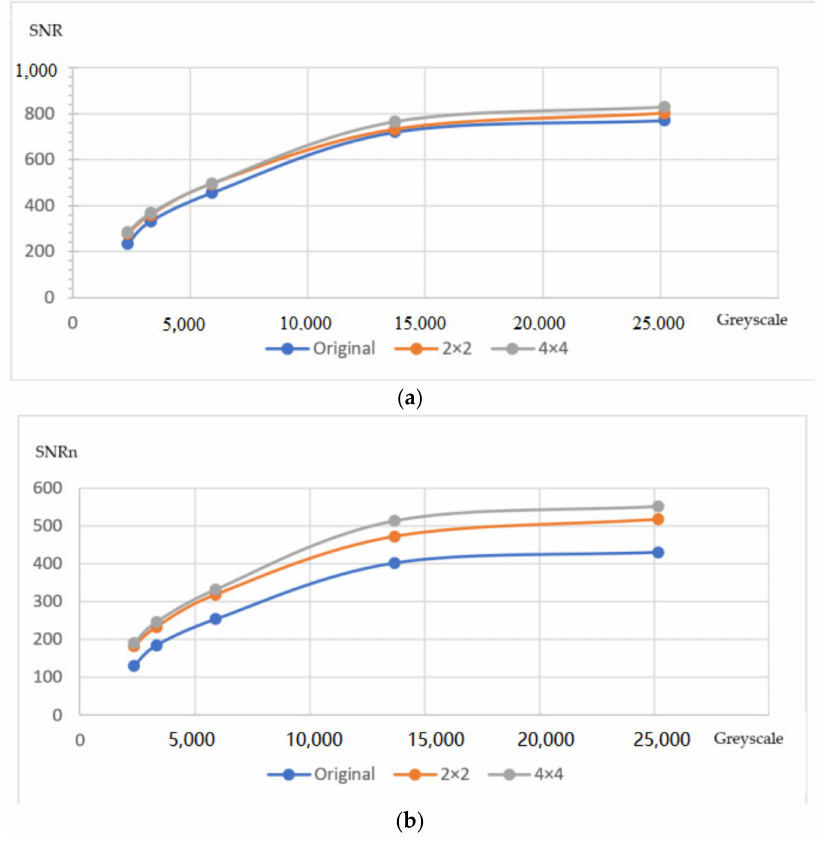
Figure 12. The SNR / SNR n of the detector: ( a ) SNR , ( b ) SNR n